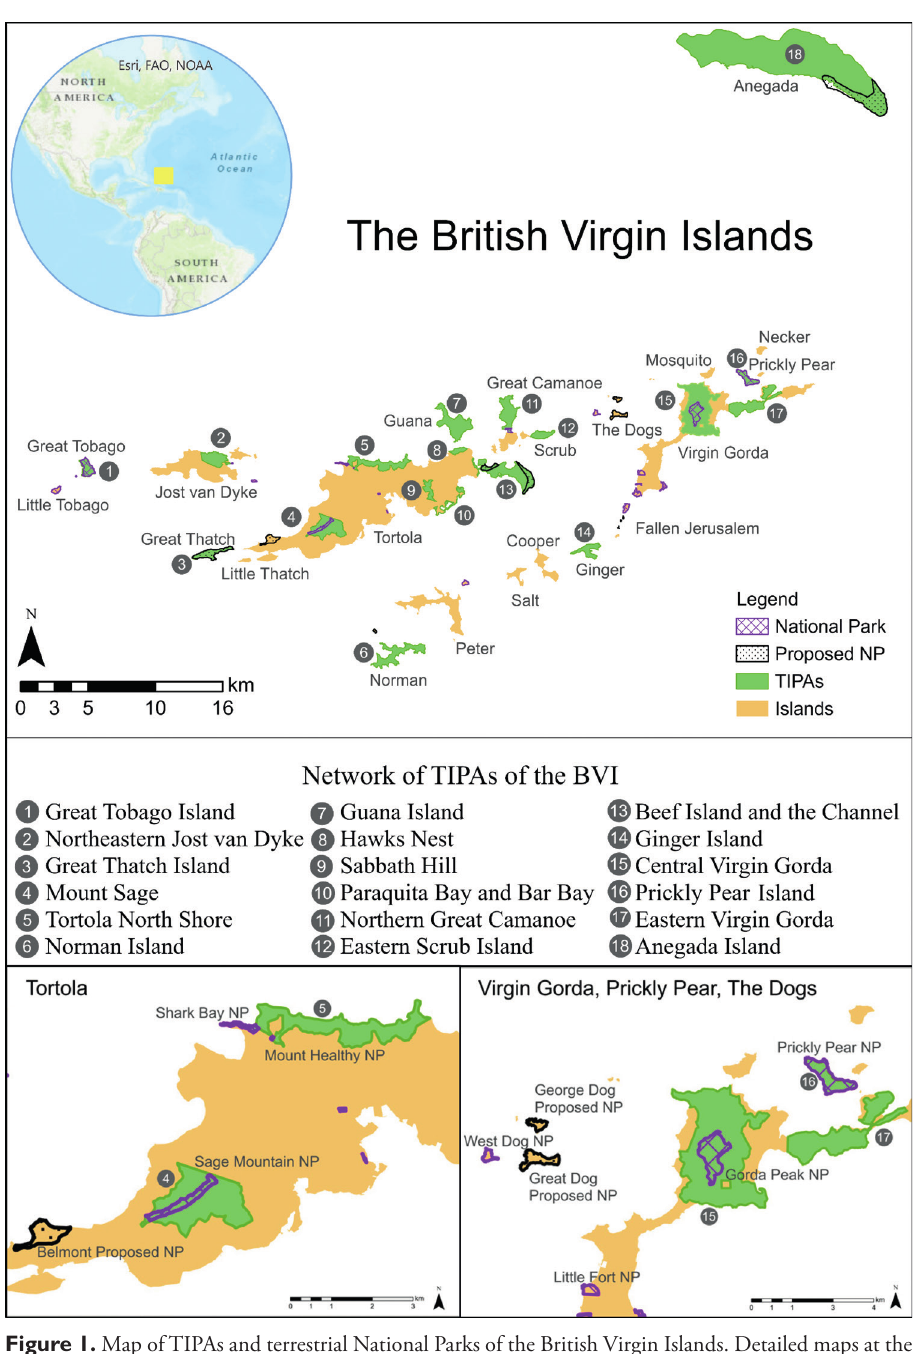
Figure 1. Map of TIPAs and terrestrial National Parks of the British Virgin Islands. Detailed maps at the bottom showing overlap of TIPAs and National Parks in those Islands. Abbreviations: Tropical Important Plant Areas (TIPAs), National Park (NP), Proposed National Park (Proposed